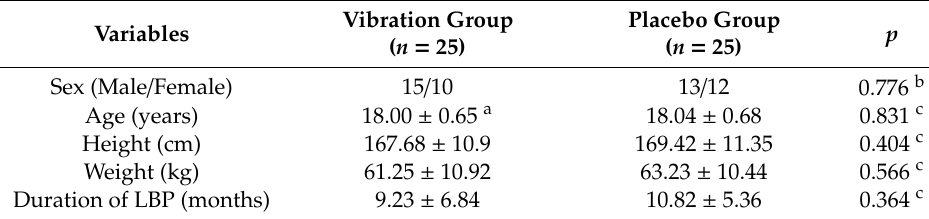
Table 1. Common and clinical characteristics of the subjects ( n =